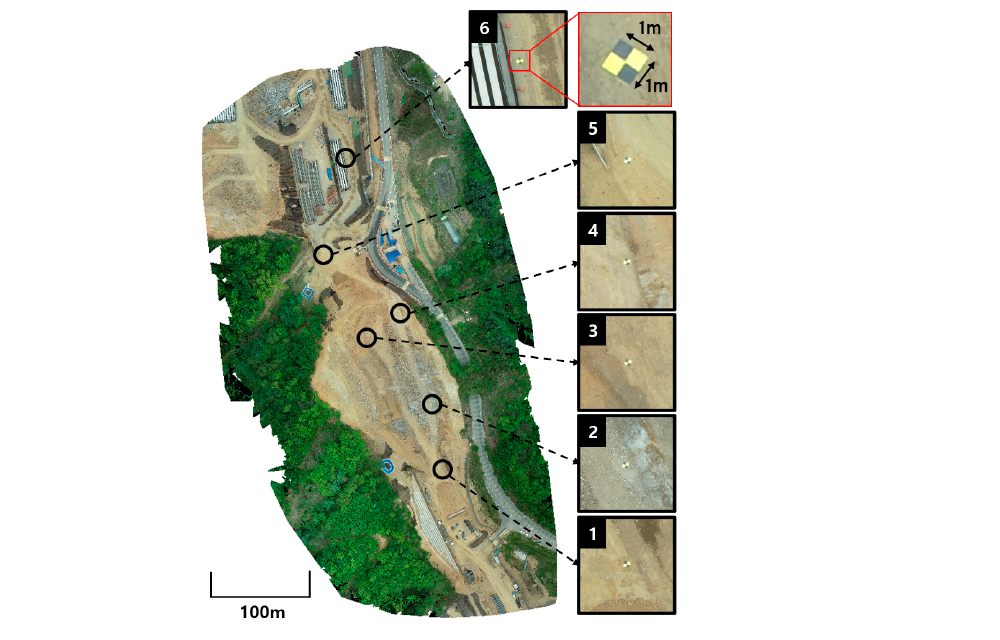
Figure 5. Entire flight area and placed GCPs.